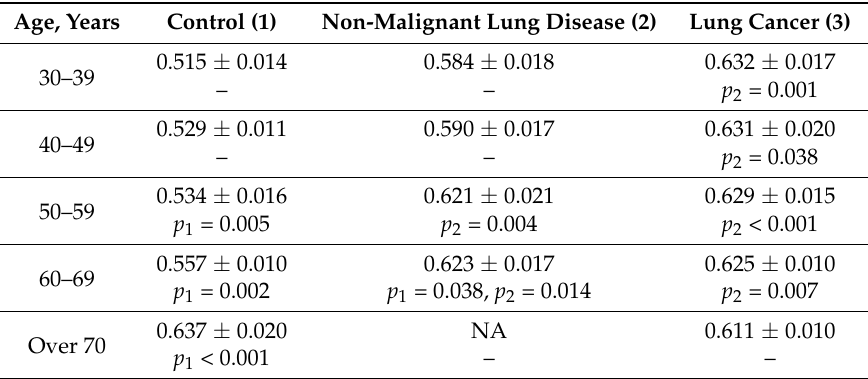
apparently healthy patients (control).